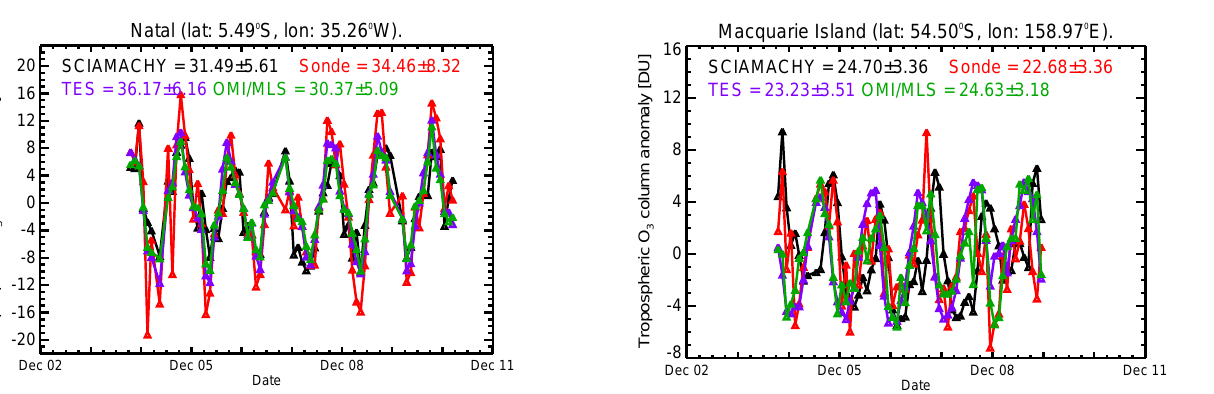
Figure 9. As Fig. 6, but over Natal (5.42 ◦ S, 35.38 ◦ W).